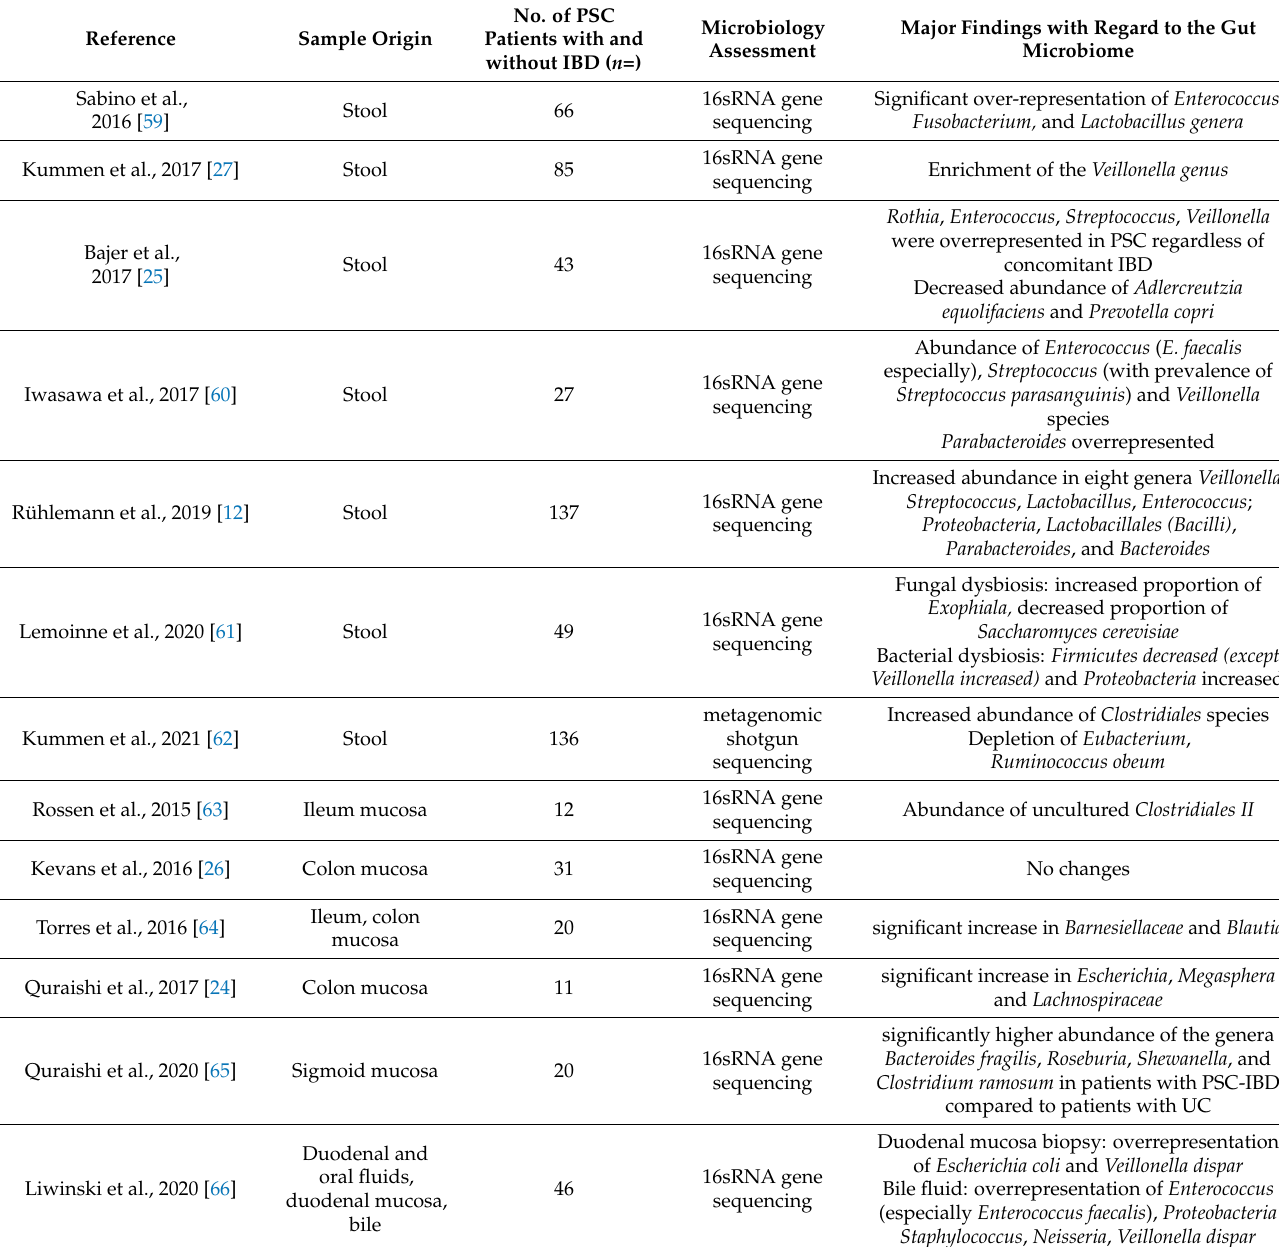
Table 1. Summary of studies analyzing fecal, mucosal, and bile samples of patients with